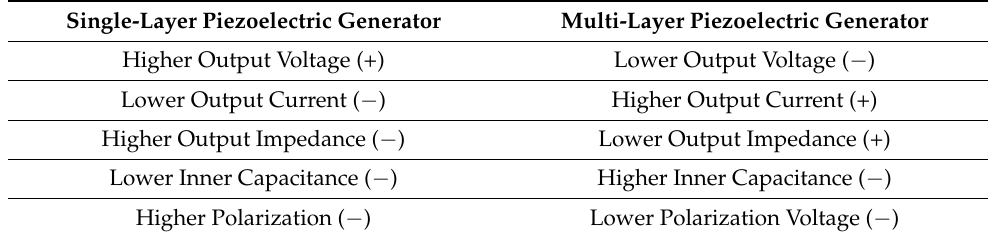
Table 1. Comparison between single-layer and multi-layer piezoelectric